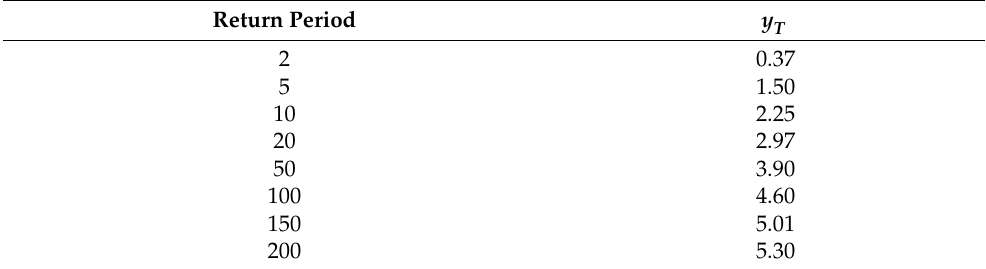
Table 5. The y T value for each return period for Tunja station.